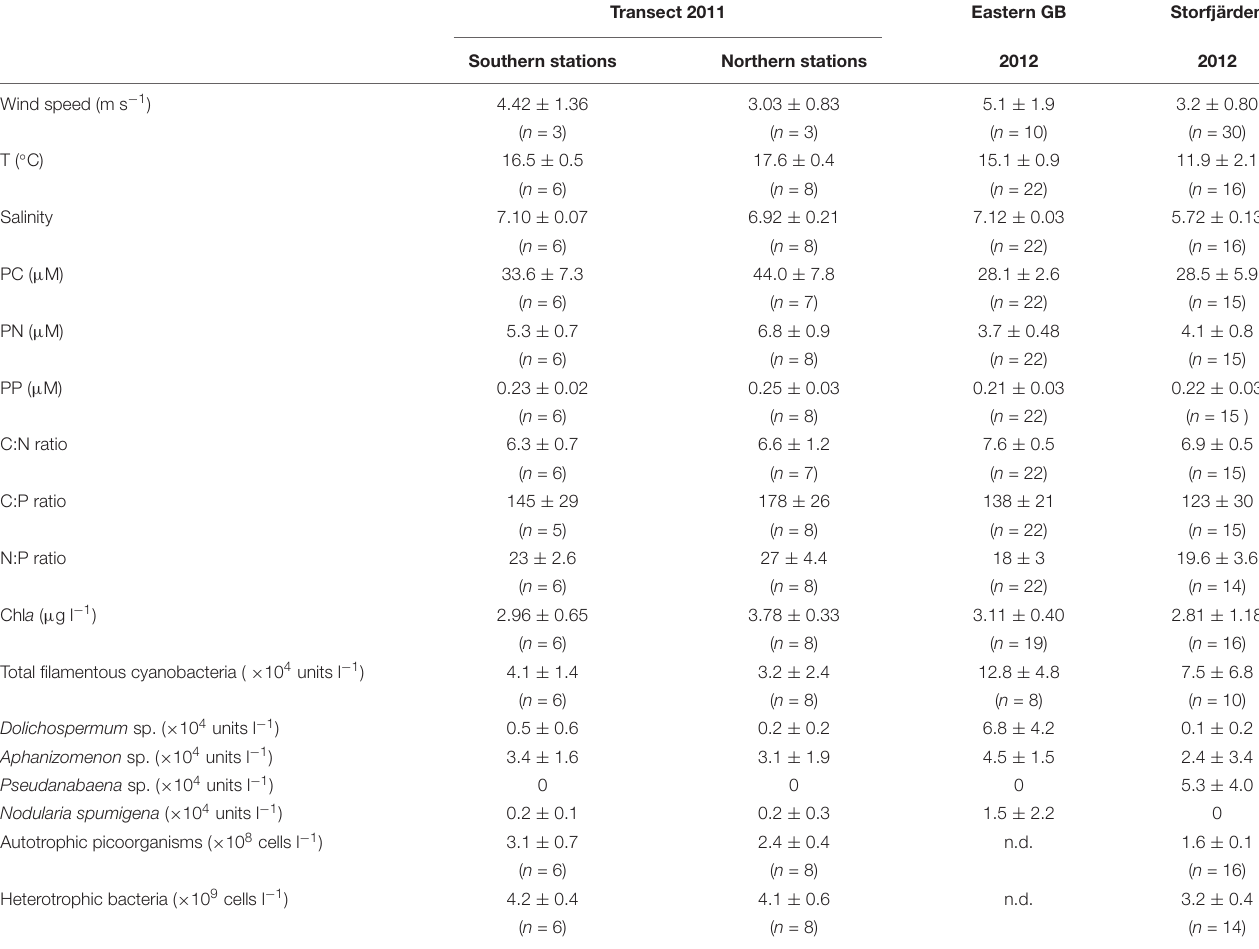
TABLE 1 | Wind, hydrographical, and biological conditions in both sub-regions of the transect in the Eastern Gotland Basin (GB) and in the